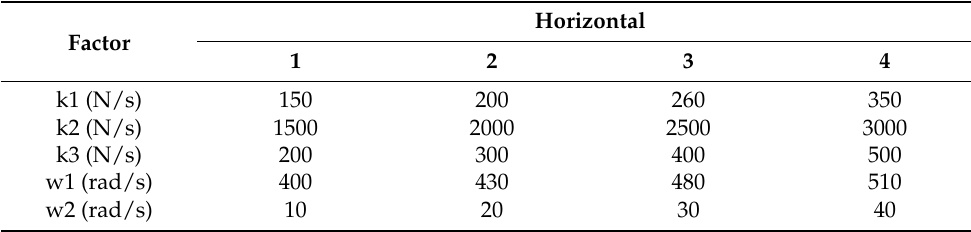
Table 4. Level table of variable slope pressure loading factors.